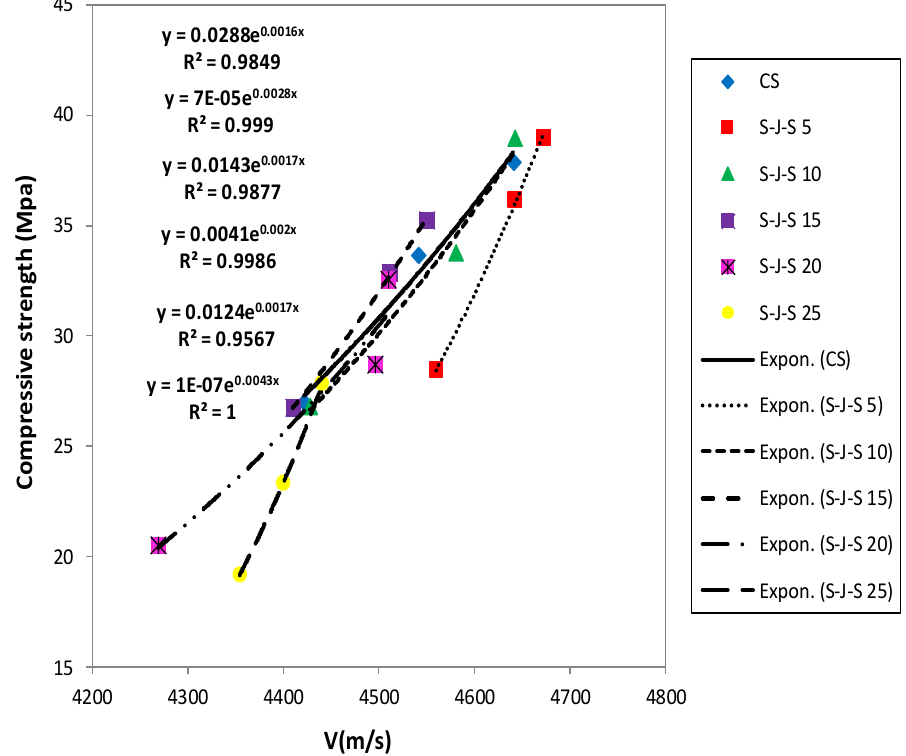
Figure 19. Relationship between UPV and compressive strength in the S-J-S group . Table 6. Exact values of empirical constants and correlation coefficients in UPV–compressive strength relationship .